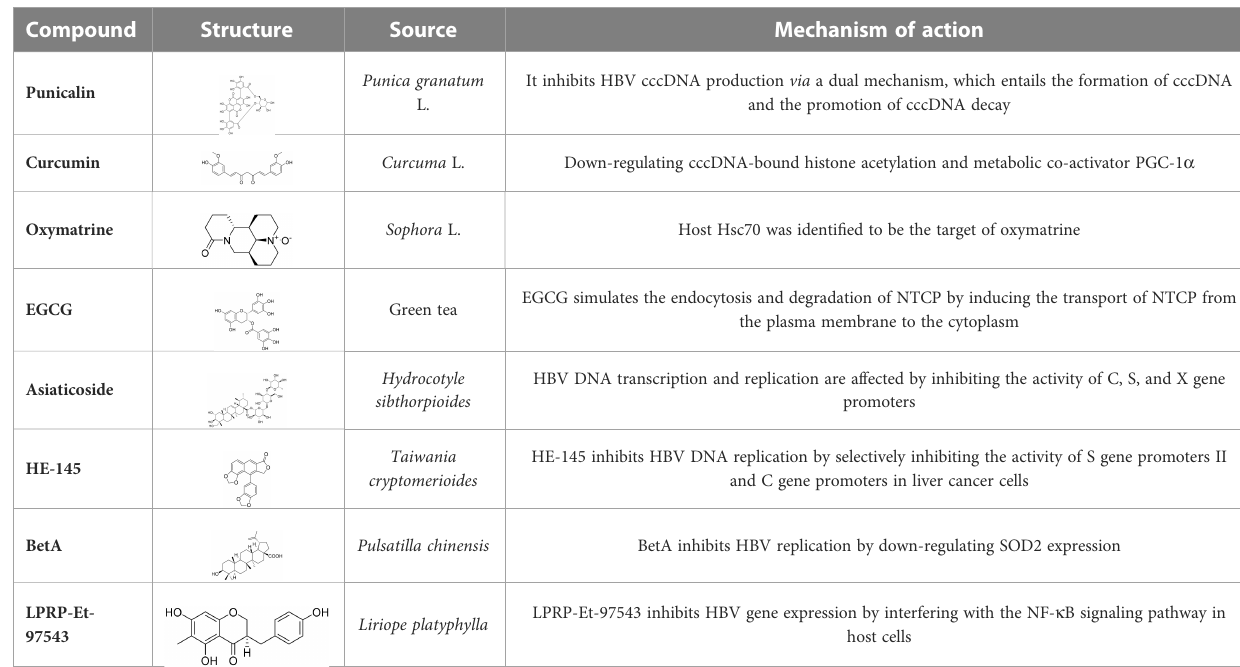
TABLE 8 A summary of representative